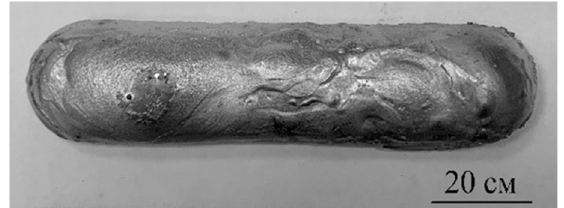
Figure 2. The final ingot.